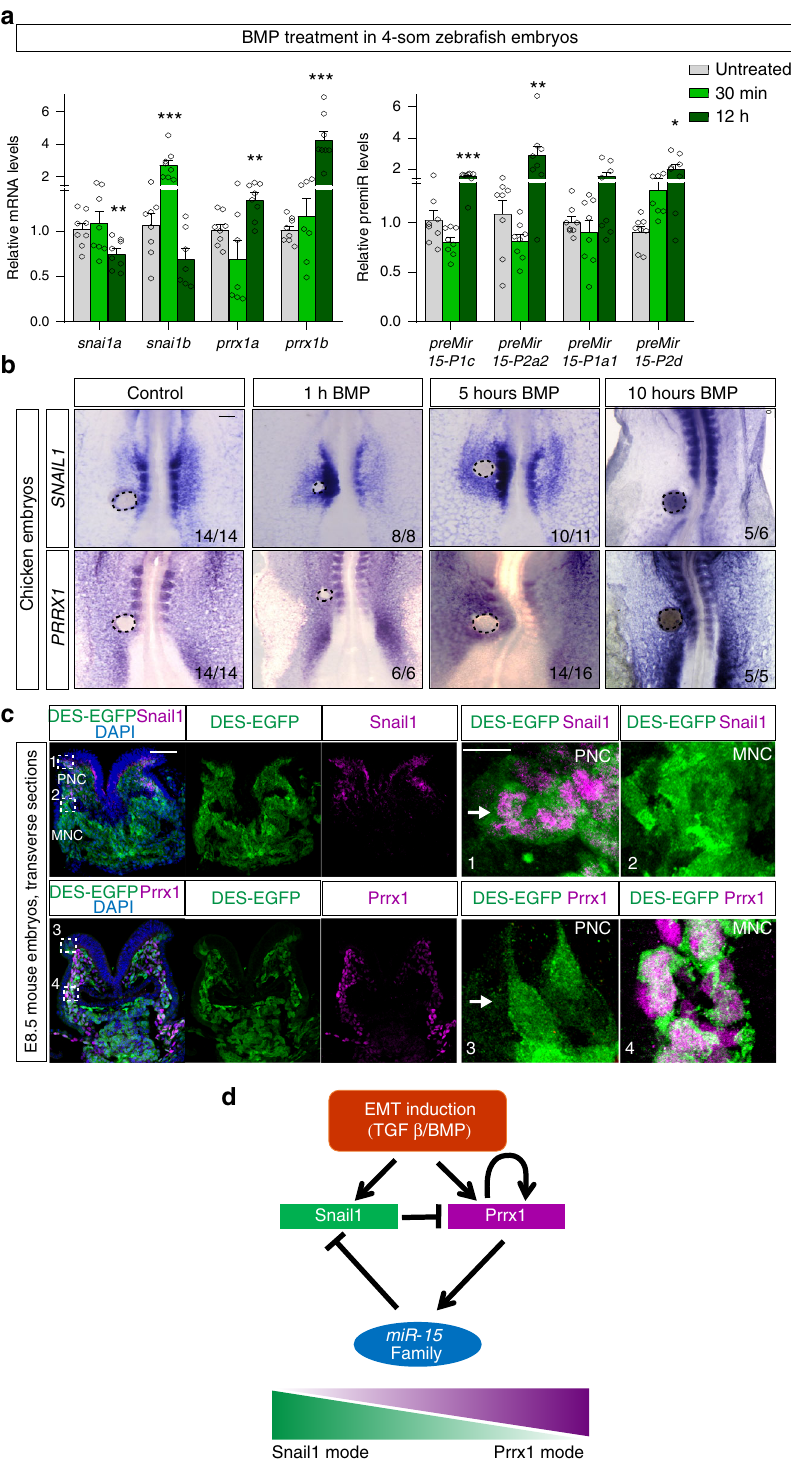
Fig. 6 Snail1 and Prrx1 are sequentially expressed during EMT. a qPCR assay showing the expression of prrx1a/b and snail1a/b (left) and premiRNAs (right) in zebra fi sh embryos after different treatments with BMP ( n = 8). Asterisks indicate signi fi cant p value in one-way ANOVA with Bonferroni ’ s multiple comparison test compared to the control. (* p < 0.05, ** p < 0.01 and *** p < 0.001). Source data are provided as a Source Data fi le. b Dorsal view of HH9 chicken embryos showing SNAIL1 and PRRX1 expression in control embryos and at different times after BMP-soaked bead implantation. c Transverse sections of E8.5 DES-EGFP reporter mouse embryos showing IFs for GFP and Snail1 (upper panel) or Prrx1 (lower panel). Insets show higher magni fi cation pictures for GFP and Snail1 (1 and 2), or for GFP and Prrx1 (3 and 4). d Schematic model of the gene regulatory network. DES downstream enhancer of Snail1, PNC premigratory neural crest shown by arrows, MNC migratory neural crest. Scale bars: 100 μ m. Scale bars: 100 μ m for sections and 10 μ m for insets (boxes 3 –